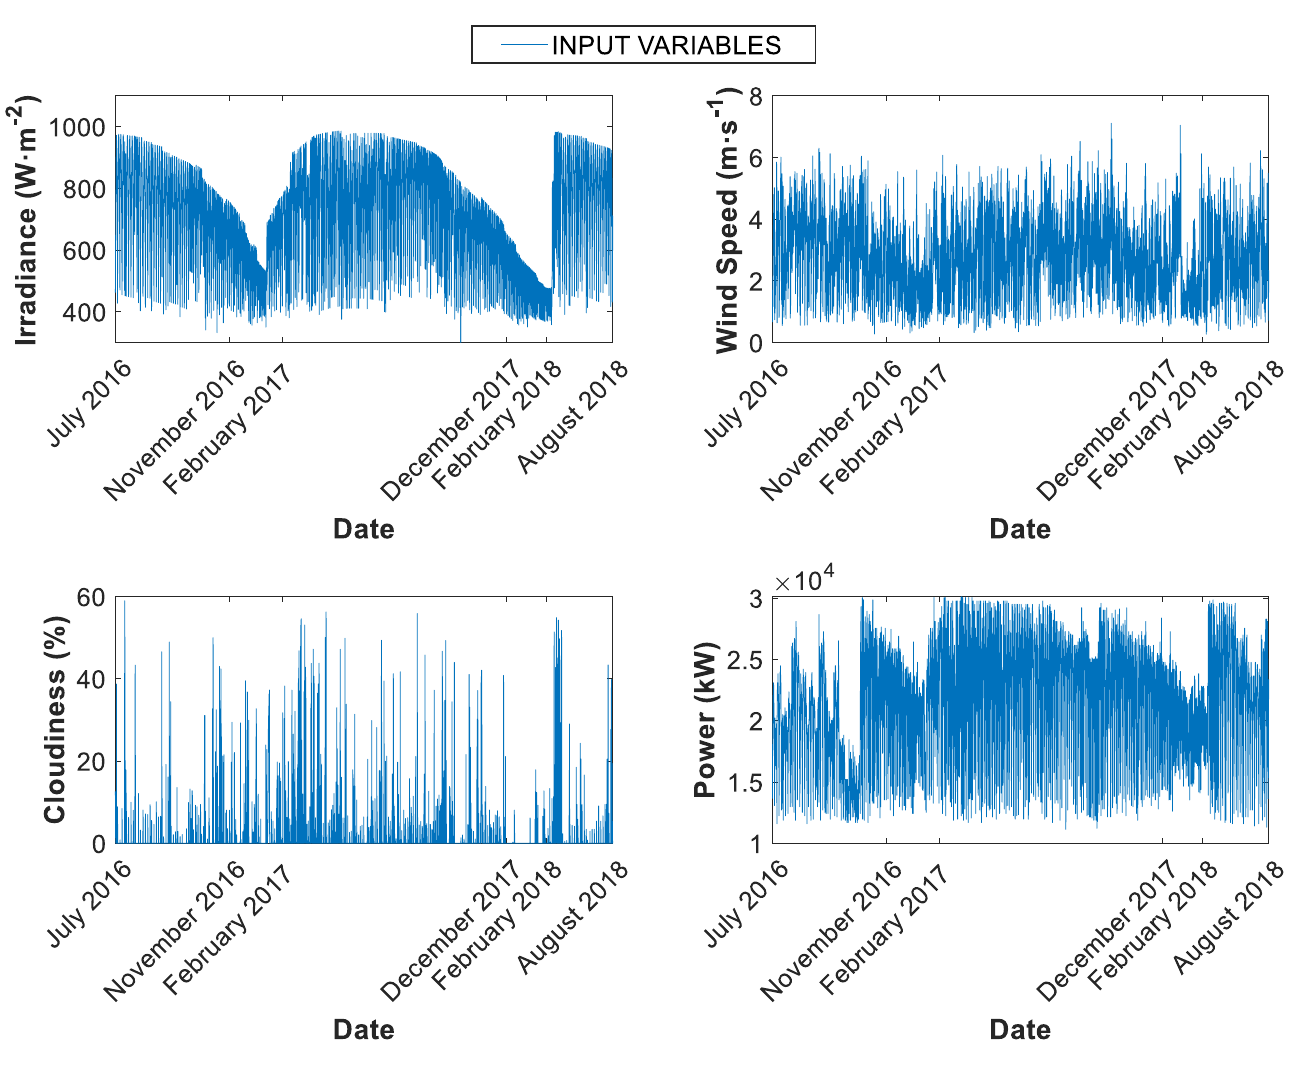
Figure 4. Graphical representation of the main input variables.